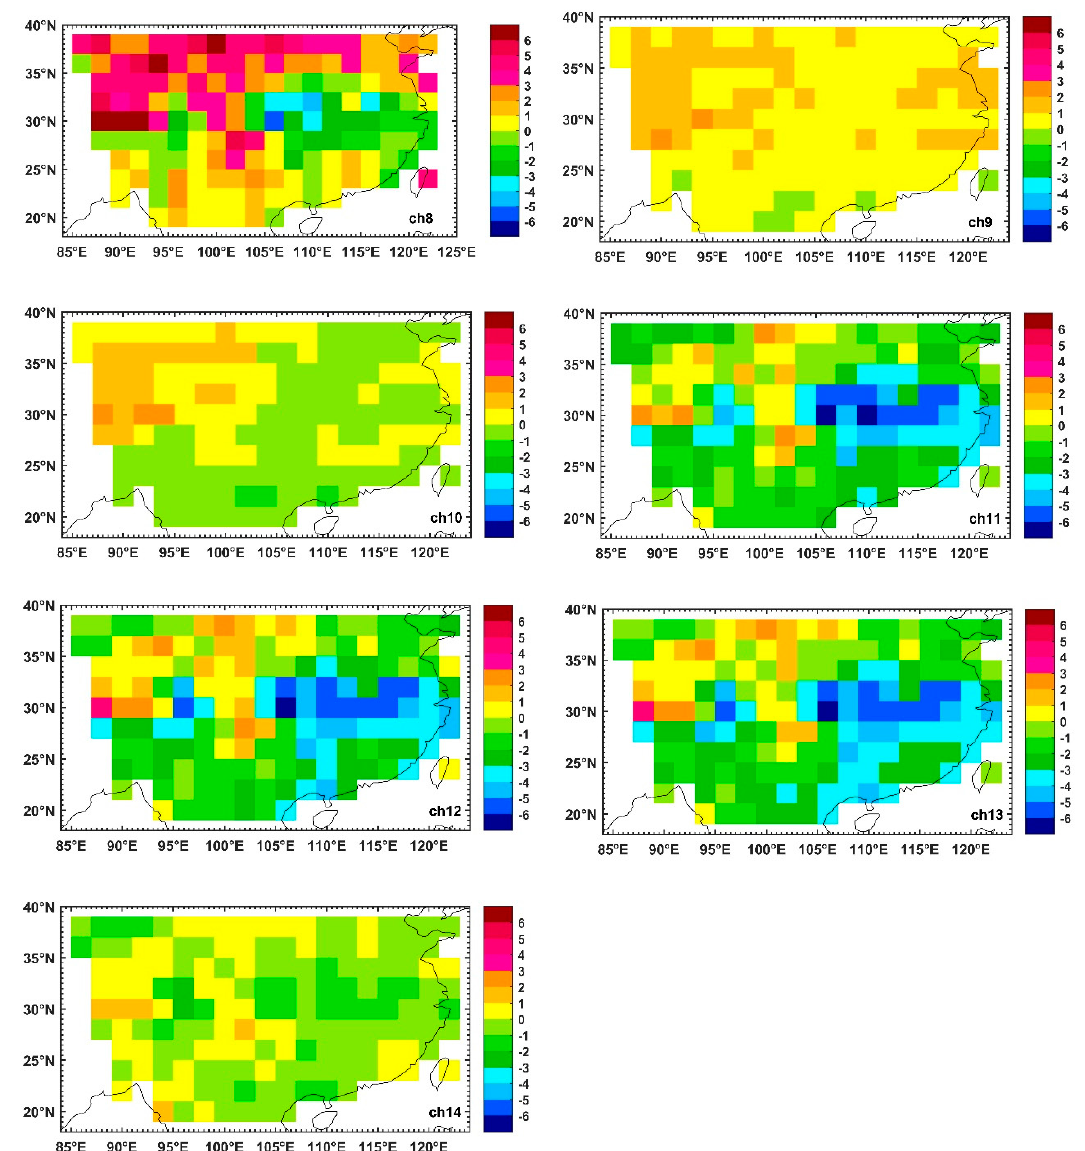
Figure 6. Spatial distributions of biases (OMB, observation minus background) of AGRI channels 8–14 over selected land area (20 ◦ N~40 ◦ N, 85 ◦ E~125 ◦ E) within 2 ◦ × 2 ◦ grid boxes.